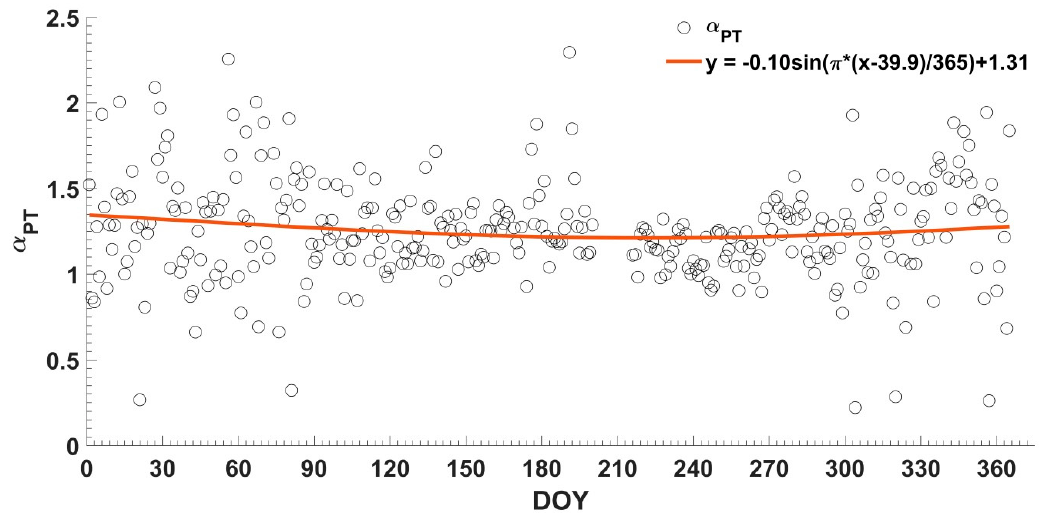
Figure 6. Seasonal variations in α in 2015.